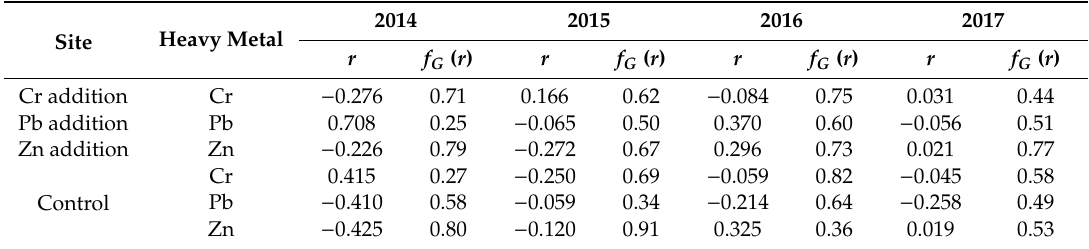
Table 4. The correlation coe ffi cient and greyness of Cr, Pb, and Zn concentrations in soil and wheat. Site